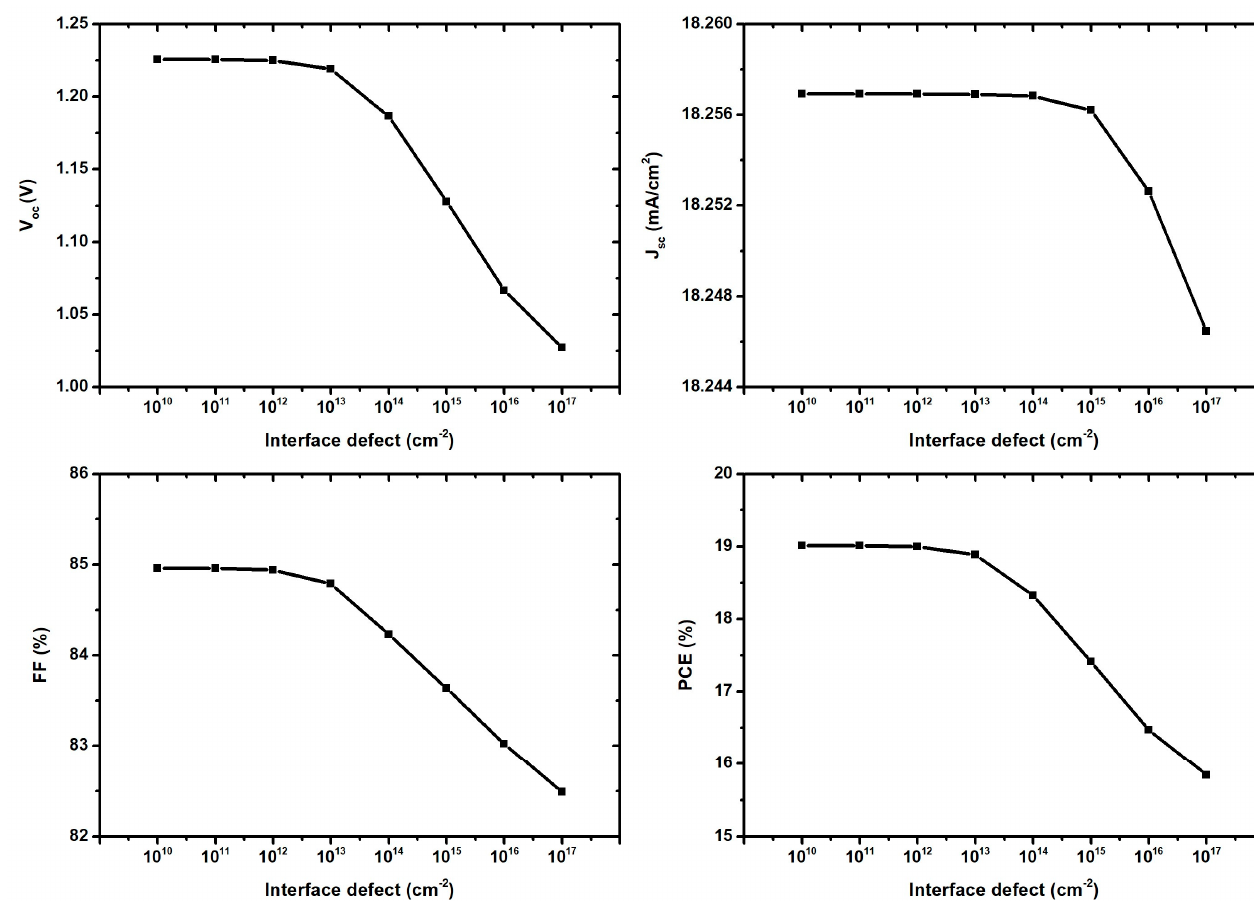
Figure 11. Variation in PV parameters for different defects at the C 2 N/ZMO